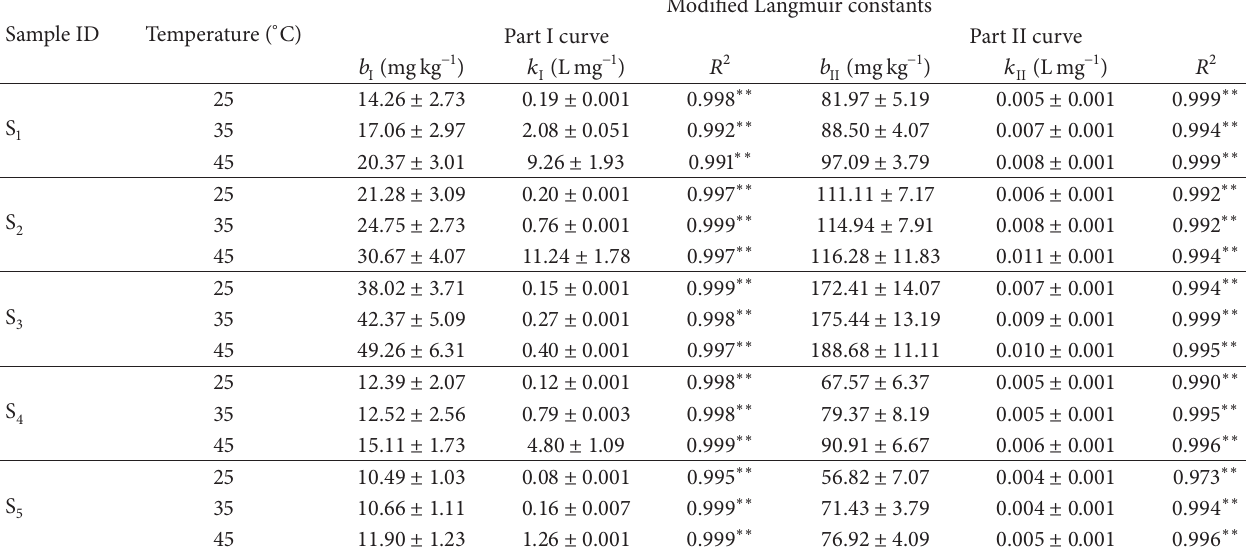
Table 3: Modified Langmuir constants of Cd sorption in soils (data represent mean of tree replications ± SD). Sample